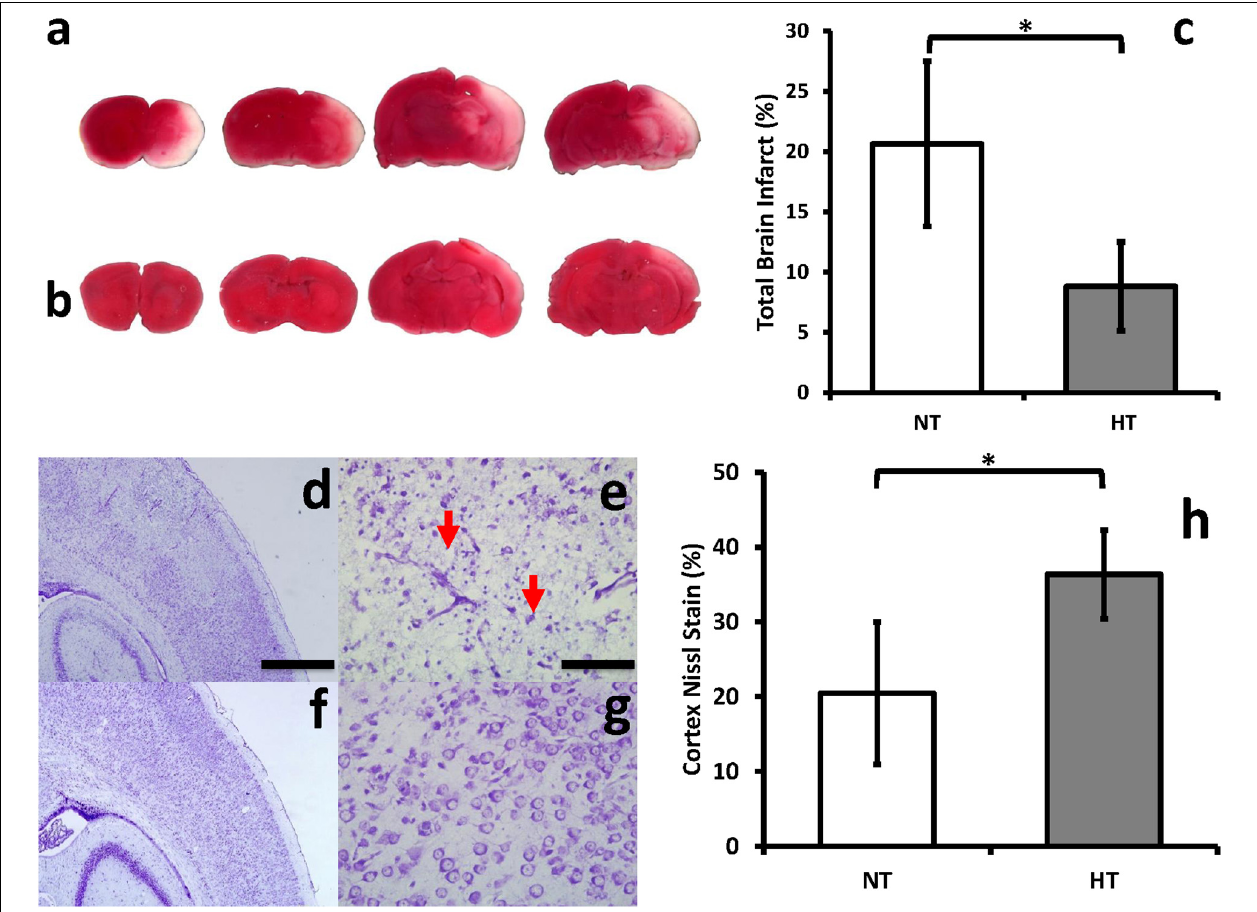
FIGURE 3 | HT decreases brain infarct size and improves neuronal integrity after HIE. Brain infarct sizes were compared between groups using TTC, which stains viable portions of the brain red. Representative brain slices for NT (a) and HT (b) animals are shown. Quantification with Image J showed that HT treatment (gray bar) significantly decreased infarct size compared to NT (white bar) animals (c) . NT (d,e) animals demonstrated significantly greater neuronal disintegration and pyknosis (red arrows) when compared to HT (f,g) animals on cresyl violet staining. Significantly greater amount of Nissl staining in the cortex was noted in HT animals (h) . [ n = 3 animals per group, cresyl violet sections depict ipsilateral hemispheres, cortex and hippocampus, 48 h after injury; Magnification – 4X (d,f) ; 20X (e,g) ; Scale bars: 4X images 500 µ m, 20X images 100 µ m; error bars denote ± SD, * denotes P < 0.05].